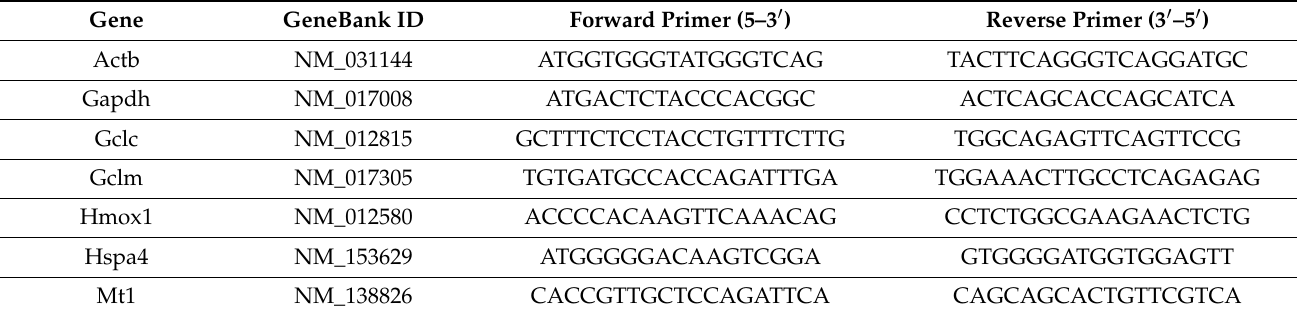
Table 5. Forward and reverse primer sequences used to analyze gene expression in rat choroid plexus epithelial cells and isolated rat choroid plexus tissues, listed by respective gene